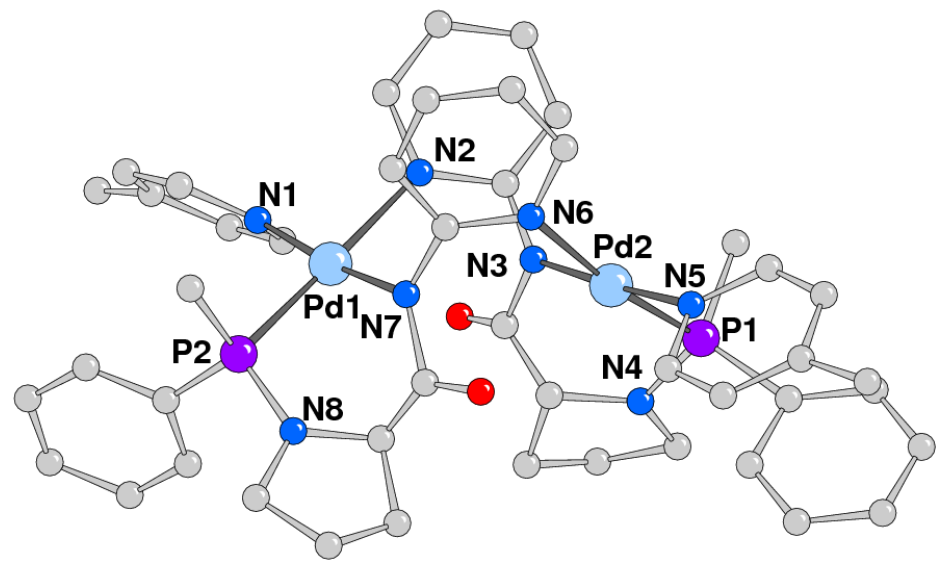
Figure 3. A perspective view of the dinuclear complex 1c